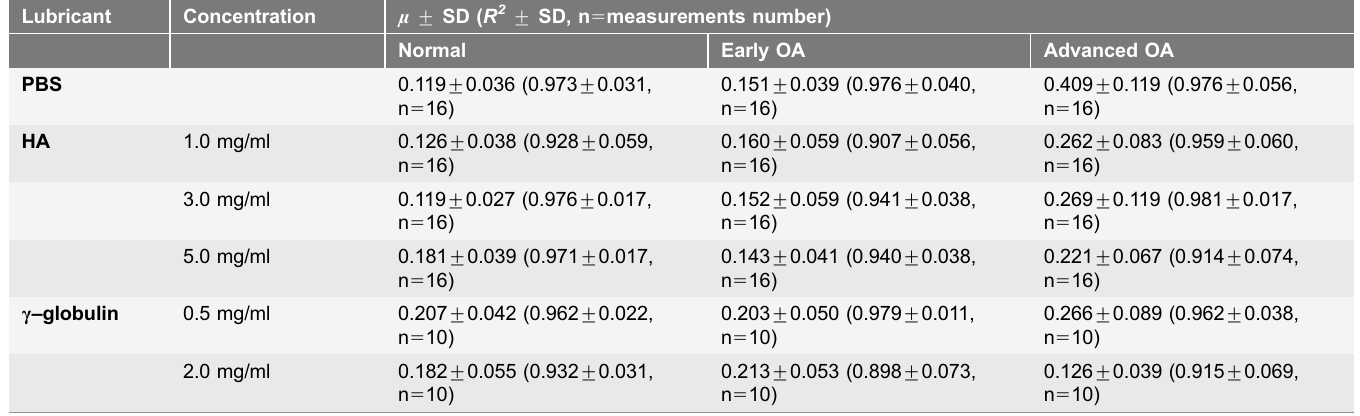
Table 2. Mean ¡ standard deviation (SD) of the microscale frictional coefficient ( m ) and correlation coefficient ( R 2 ) for human OA cartilage measured in PBS, HA, and c –globulin. Lubricant